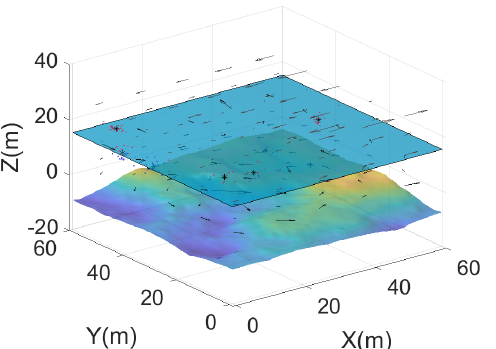
Figure 14. An example of current fields. The field are for underwater and aerial environments. We made the assumption that the surface of the water will remain flat during transitions of the vehicle from air to water, and vice